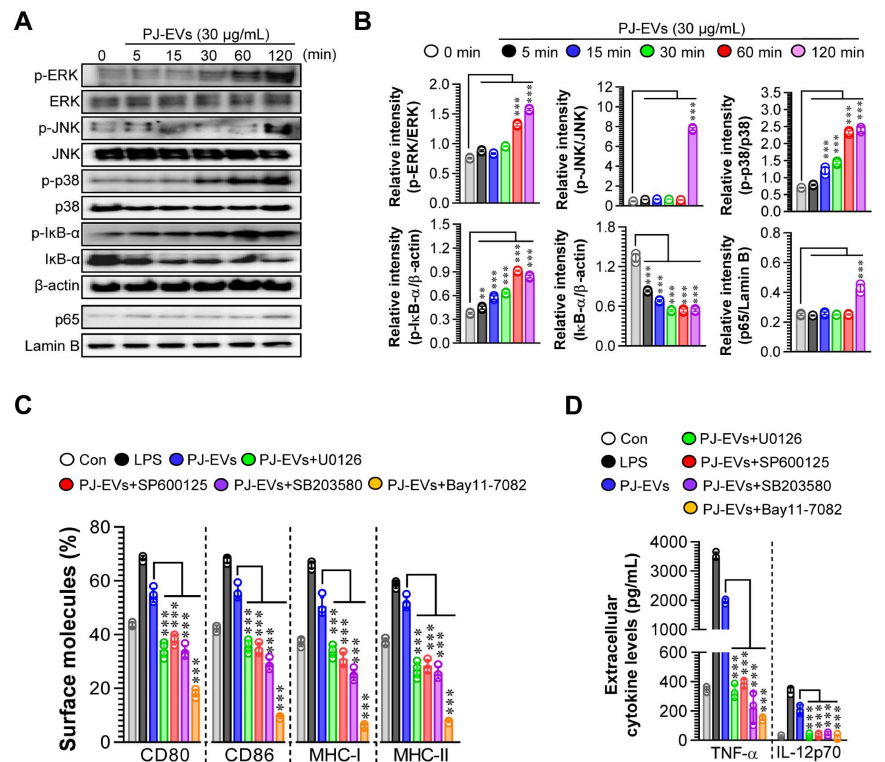
Figure 4. Activation of MAPK and NF- κ B signaling pathways in DCs treated with PJ-EVs. ( A ) DCs were incubated with PJ-EVs (30 µ g/mL) for different times. After incubation, these cells were lysed for protein extraction. SDS-PAGE and immunoblotting analyses were performed to assess the maturation signal using phosphorylated antigen-specific and total antigen-specific antibodies against ERK, JNK, p38, IkB- α , and NF- κ B. Data are representative of three independent experiments. ( B ) Western blotting data were assessed using the Image J software to compare the phosphorylated and total forms. ( C , D ) DCs pretreated with MAPK and NF- κ B signaling pathway inhibitors, U0126 (ERK inhibitor, 10 µ M), SP600125 (JNK inhibitor, 20 µ M), SB203580 (p38 inhibitor, 20 µ M), and Bay11- 7082 (NF- κ B inhibitor, 10 µ M), were incubated with PJ-EVs (30 µ g/mL) for 18 h. ( C ) Expression levels of surface molecules (CD80, CD86, MHC-I, and MHC-II) on cells analyzed by FACS. ( D ) Levels of extracellular cytokines (TNF- α and IL-12p70) were analyzed using ELISA. The results are indicated as mean ± SD (n = 4 samples) of three representative experiments. ** p < 0.01, or *** p < 0.001. SD: standard